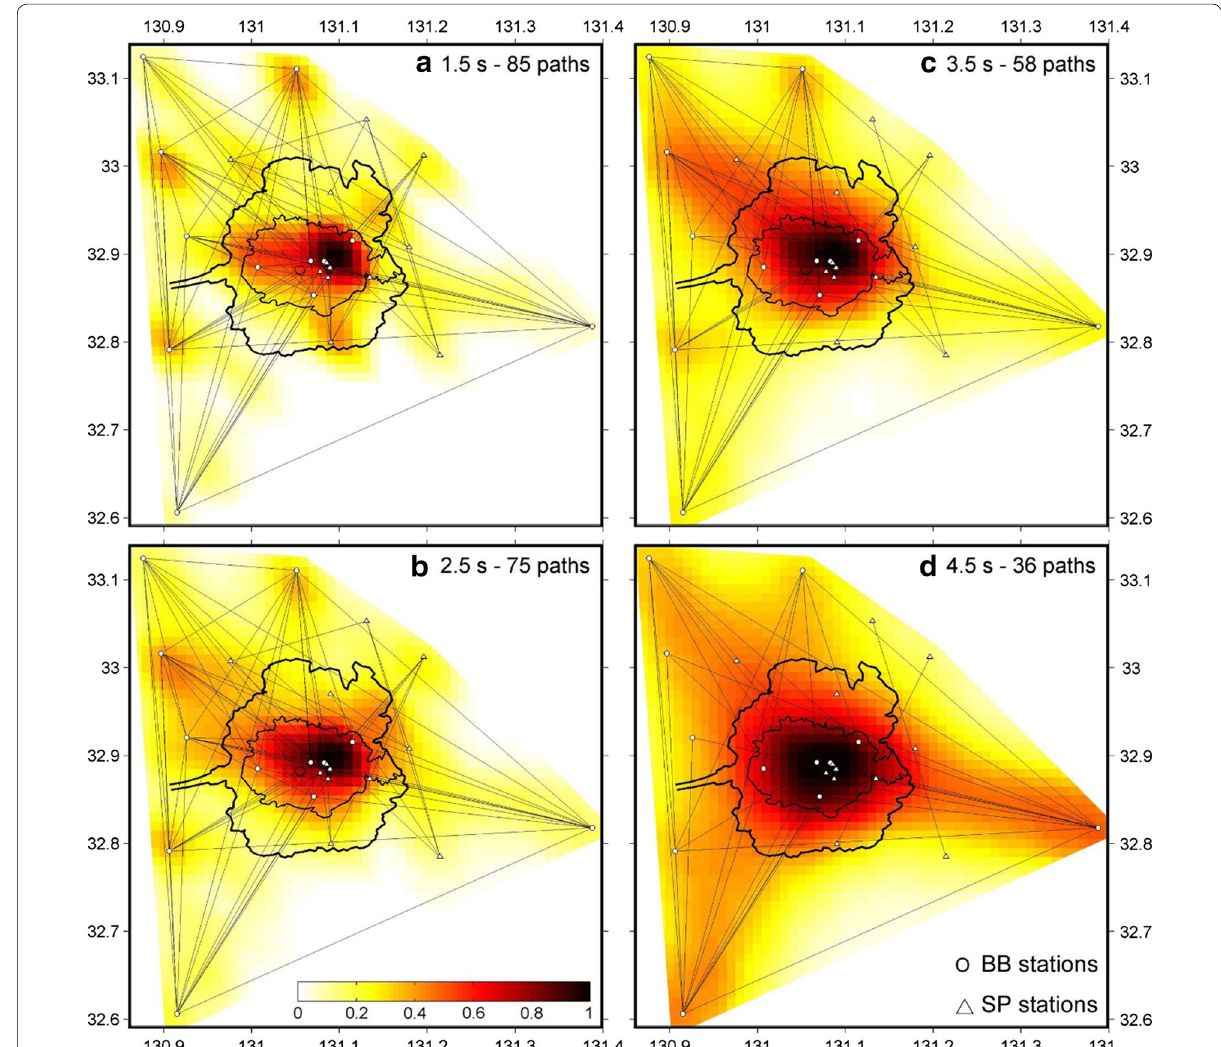
Fig. 9 Path number, coverage, and normalized relative path density of the phase‑velocity measurements for four arbitrarily selected periods: a 1.5, b 2.5, c 3.5, and d 4.5 s. Regions without path coverage are